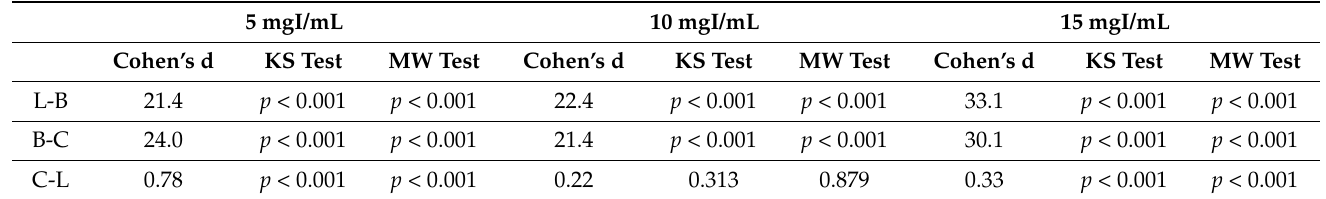
Table 1. Results from statistical analysis, including Cohen’s d, Kolmogorov-Smirnov and Mann-